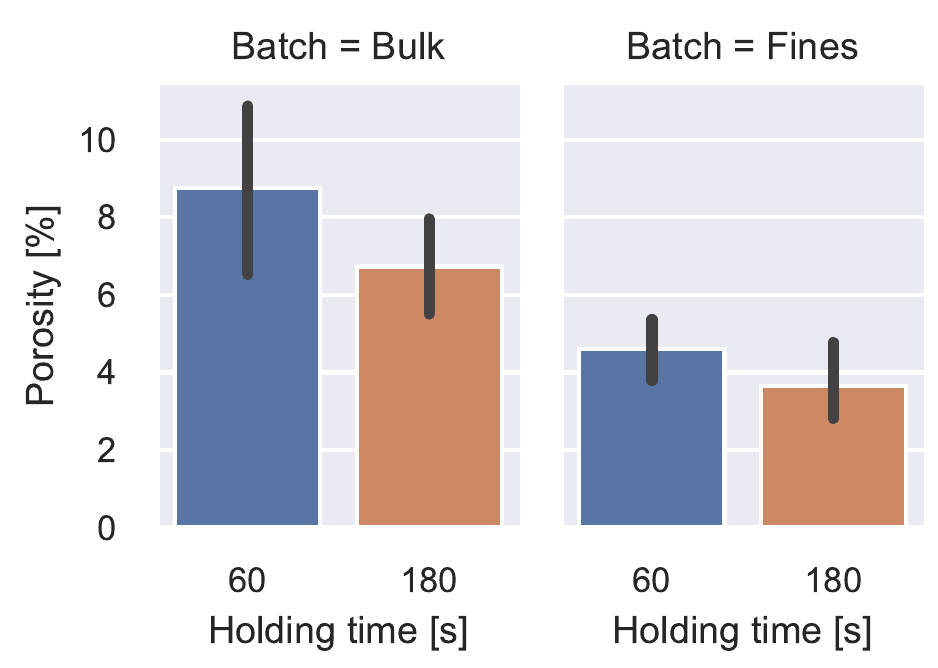
Figure 7. Mean porosity for the bulk and fine samples for the different holding times, reported as a percentage of pores relative to the entire horizontal cross-sectional area of the sample (including the